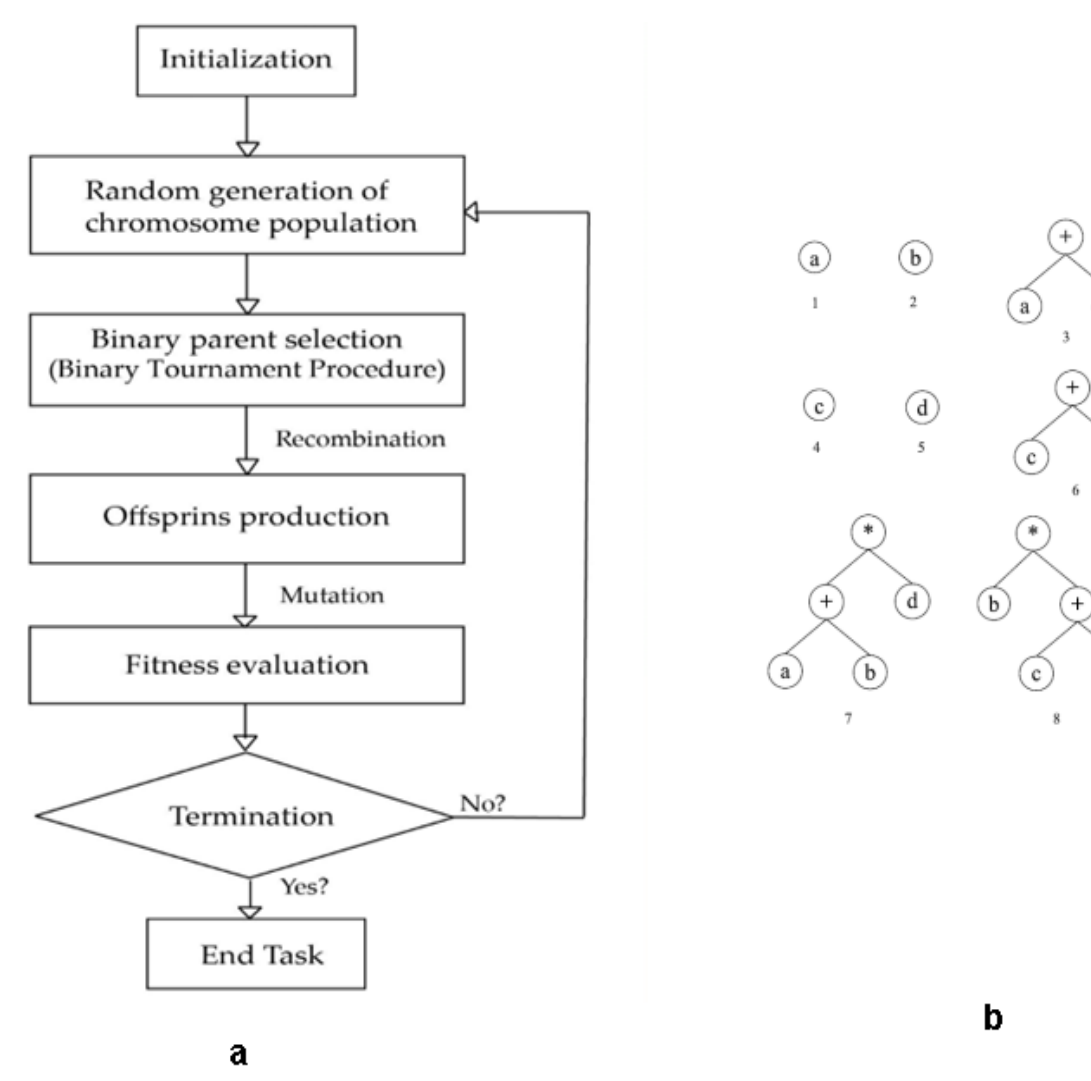
Figure 4. ( a ) Procedures involved in implementing MEP, ( b ) Flowchart for expressions encoded by an MEP chromosome.